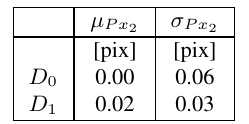
Table 1: Limoge; µ Px of the residual parallax computed for across-track stereo